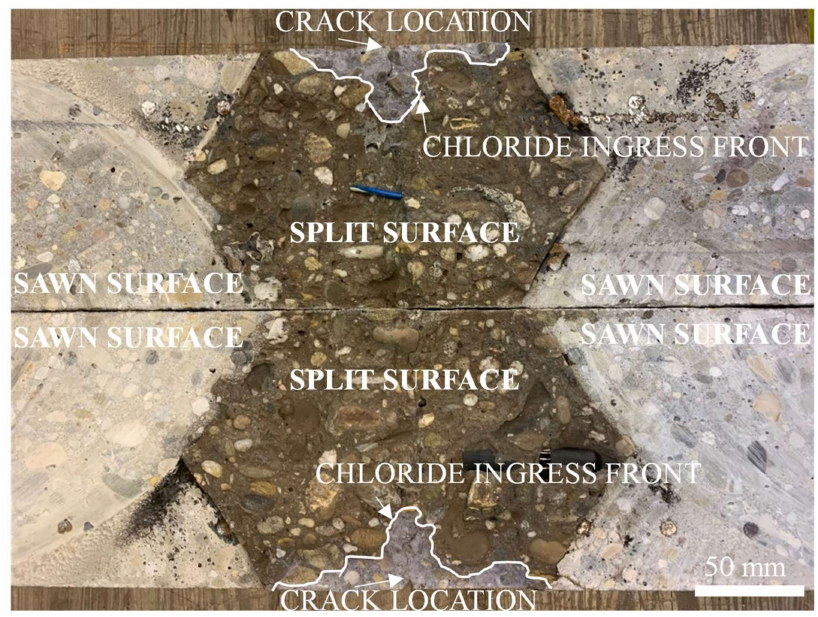
Figure 4. Visualization of the chloride ingress front on both surfaces obtained after splitting open of the